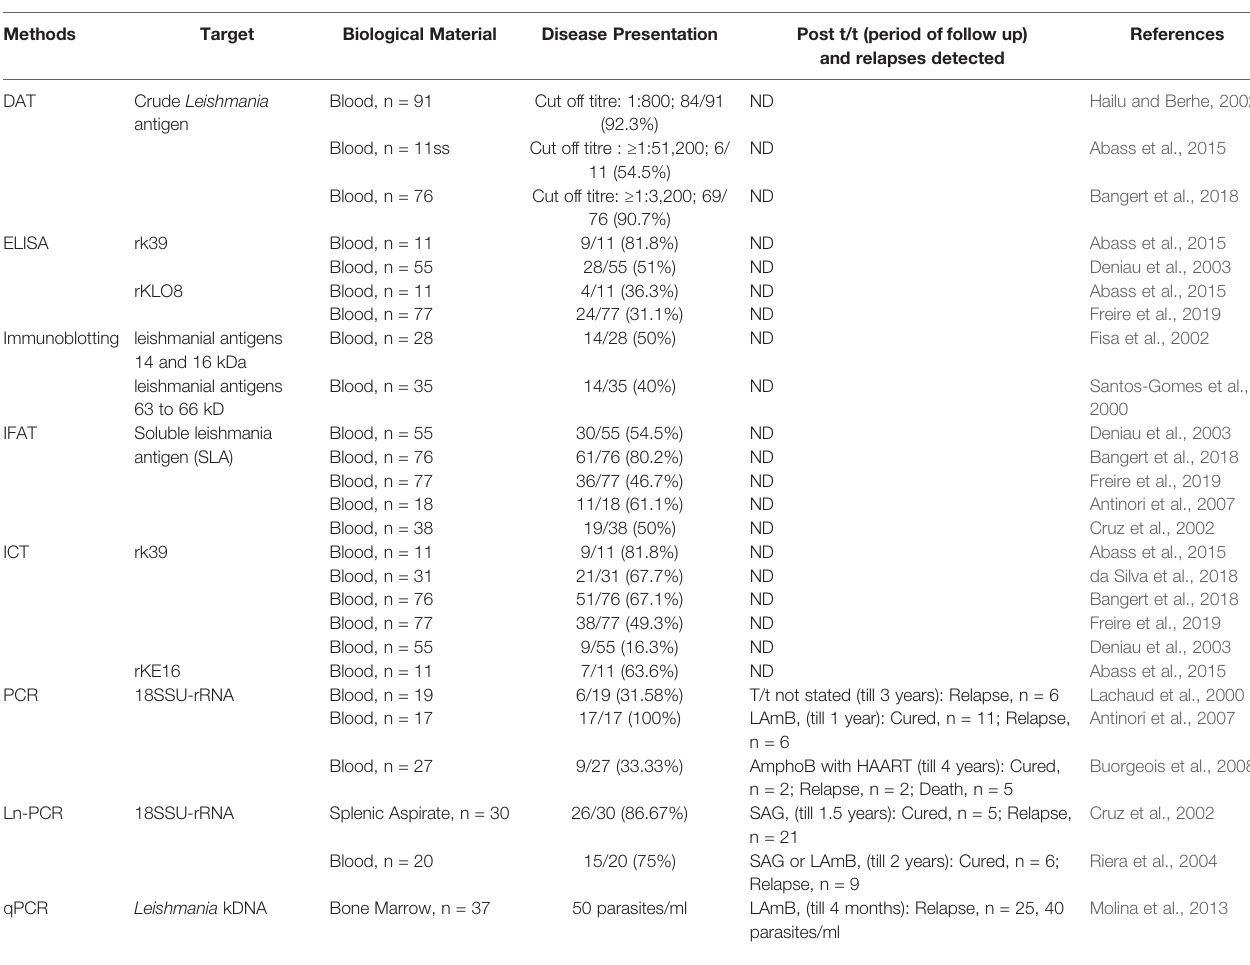
TABLE 3 | Antibody and Nucleic Acid Markers of